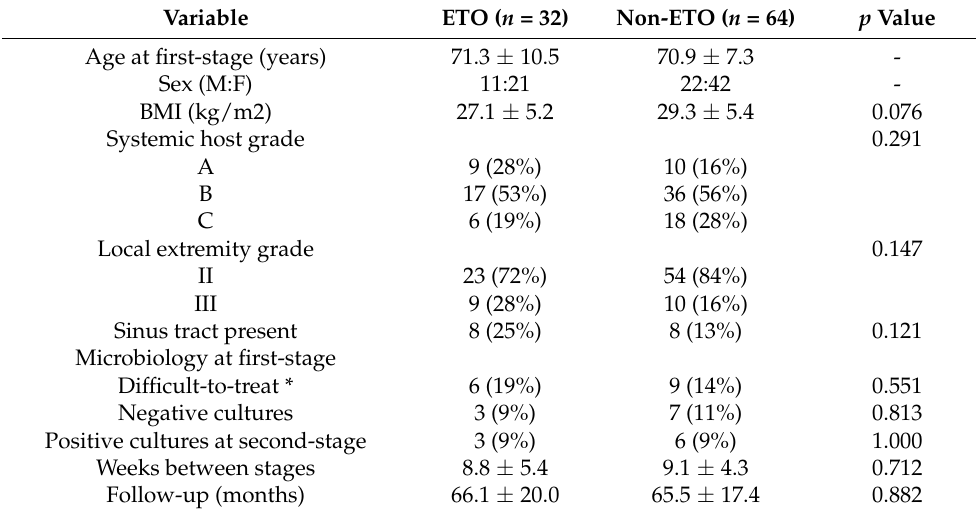
Table 3. Comparison of demographic data between ETO and non-ETO